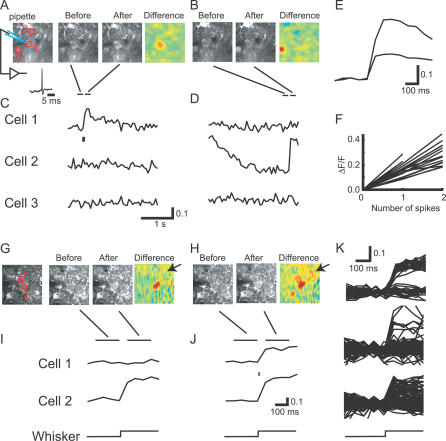
Spontaneous and Whisker Stimulation-Evoked Fluorescence Transients in the Somata of Cortical Neurons(A) Images of spontaneous fluorescence transients. The left image shows three regions of interest corresponding to three cells over 3 s. The electrophysiological recording was performed from Cell 1. The subsequent two images show the fluorescence before and after onset of the transient in Cell 1, averaged over the time periods indicated by horizontal bars in (C) and (D). The third image shows the difference image.(B) Different 3-s trial, same region as in (A).(C) Fluorescence changes corresponding to (A). The tick mark indicates an AP recorded from Cell 1 using a cell-attached electrode. See also Video S1.(D) Fluorescence changes corresponding to (B). In this trial, Cell 1 did not produce an AP.(E) Averaged fluorescence transients following one and two spikes (Cell 1 in [A–D]). The ratio of the amplitudes is a factor of two.(F) The peak fluorescence change as a function of the number of APs (18 cells).(G and H) Examples of whisker stimulation-evoked fluorescence transients. Cell-attached recordings were made from Cell 1. In (G), only Cell 2 produced a fluorescence transient. In (H), both cells produced a transient. Note the diffuse neuropil signal (arrows).(I and J) Fluorescence changes corresponding to (G) and (H), respectively. Whisker stimuli are indicated on the bottom.(K) Fluorescence traces from different trials were overlaid. Top, traces corresponding to Cell 1 (G–J). Trials producing whisker stimulation-evoked transients (successes) were easily distinguished from trials without transients (failures). Middle and bottom, traces from other cells. In these cells, the separation between successes and failures was less clear.